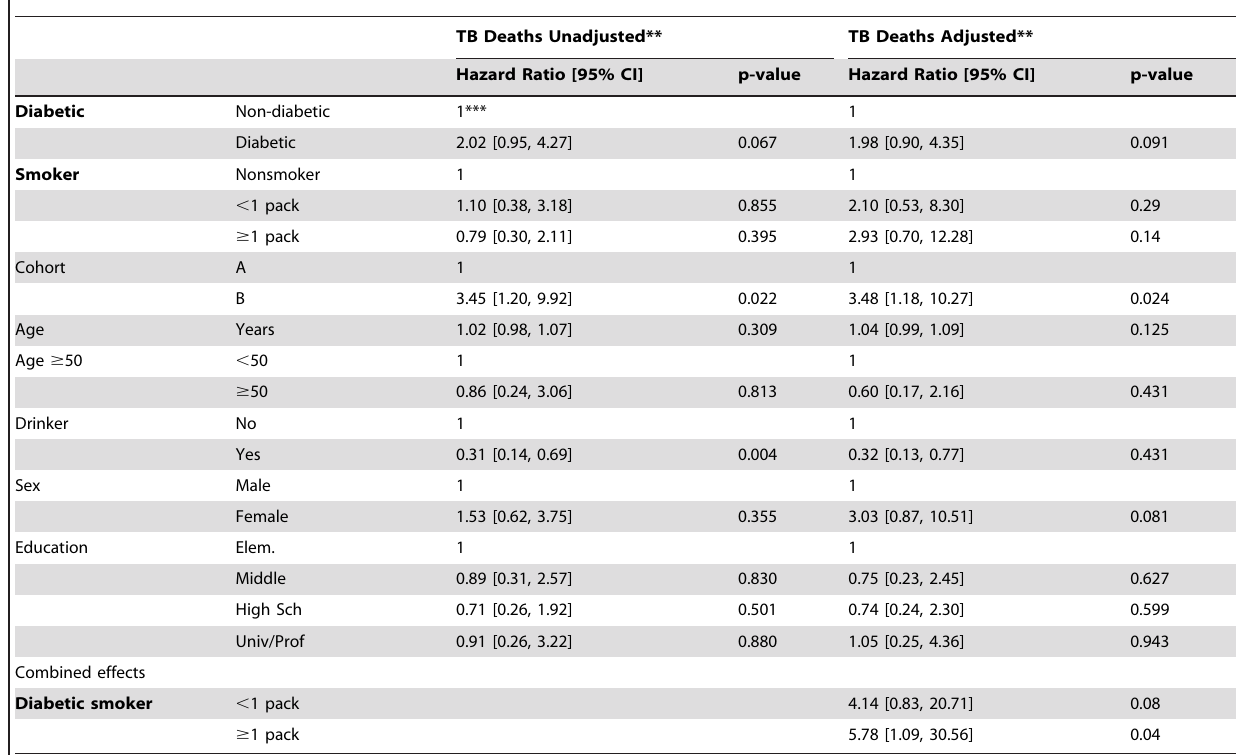
Table 6. Impact of diabetes and smoking on one-year mortality attributable to